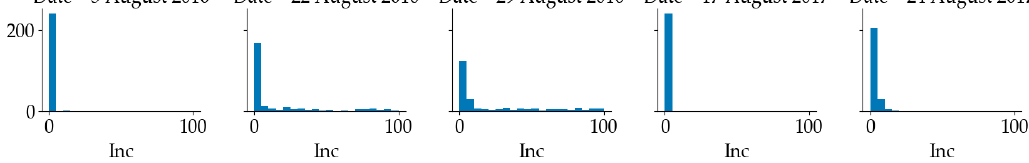
Figure 3. Distribution of sudden death syndrome (SDS) incidence in soybean quadrats (Inc: Incidence) at Marsden Farm.